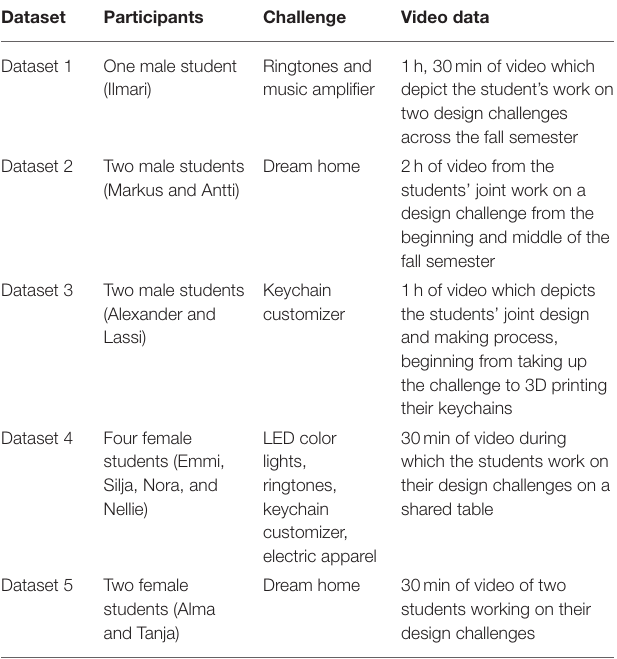
TABLE 2 | Summary of the data